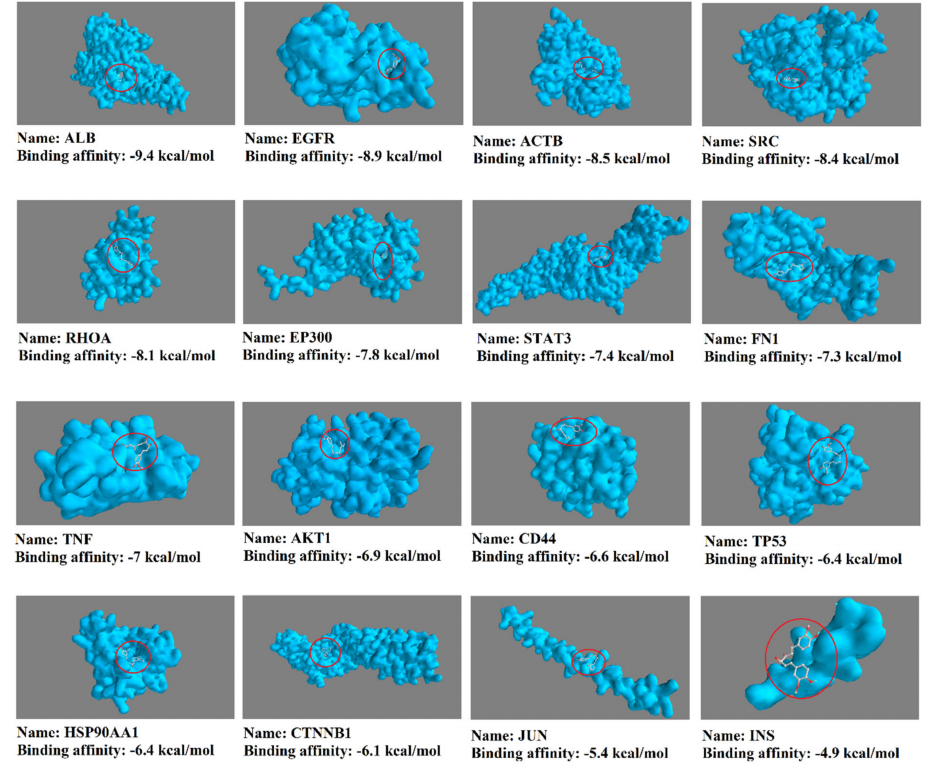
Figure 7. The possible interaction of curcumin with proteins encoded by 16 hub genes using the molecular docking